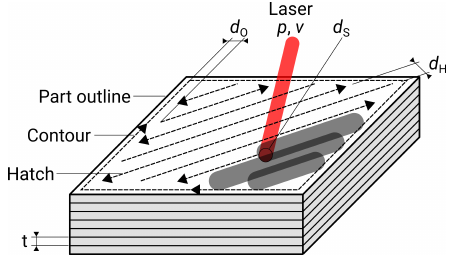
Figure 3. Exposure strategy and process parameters in selective laser melting